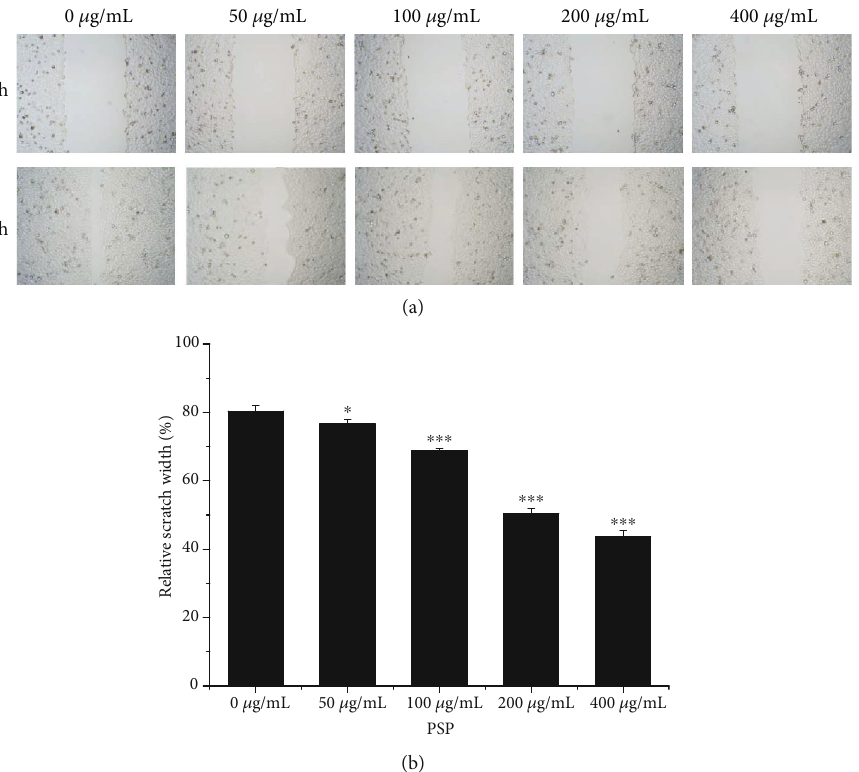
Figure 4: PSP inhibited migration and invasion of Eca109 cells. (a) The migration and invasion of Eca109 cells in each group determined by in vitro scratch assay. (b) Quantitative results of (a), compared with the control group, ∗ p < 0 : 05 and ∗∗∗ p < 0 : 001